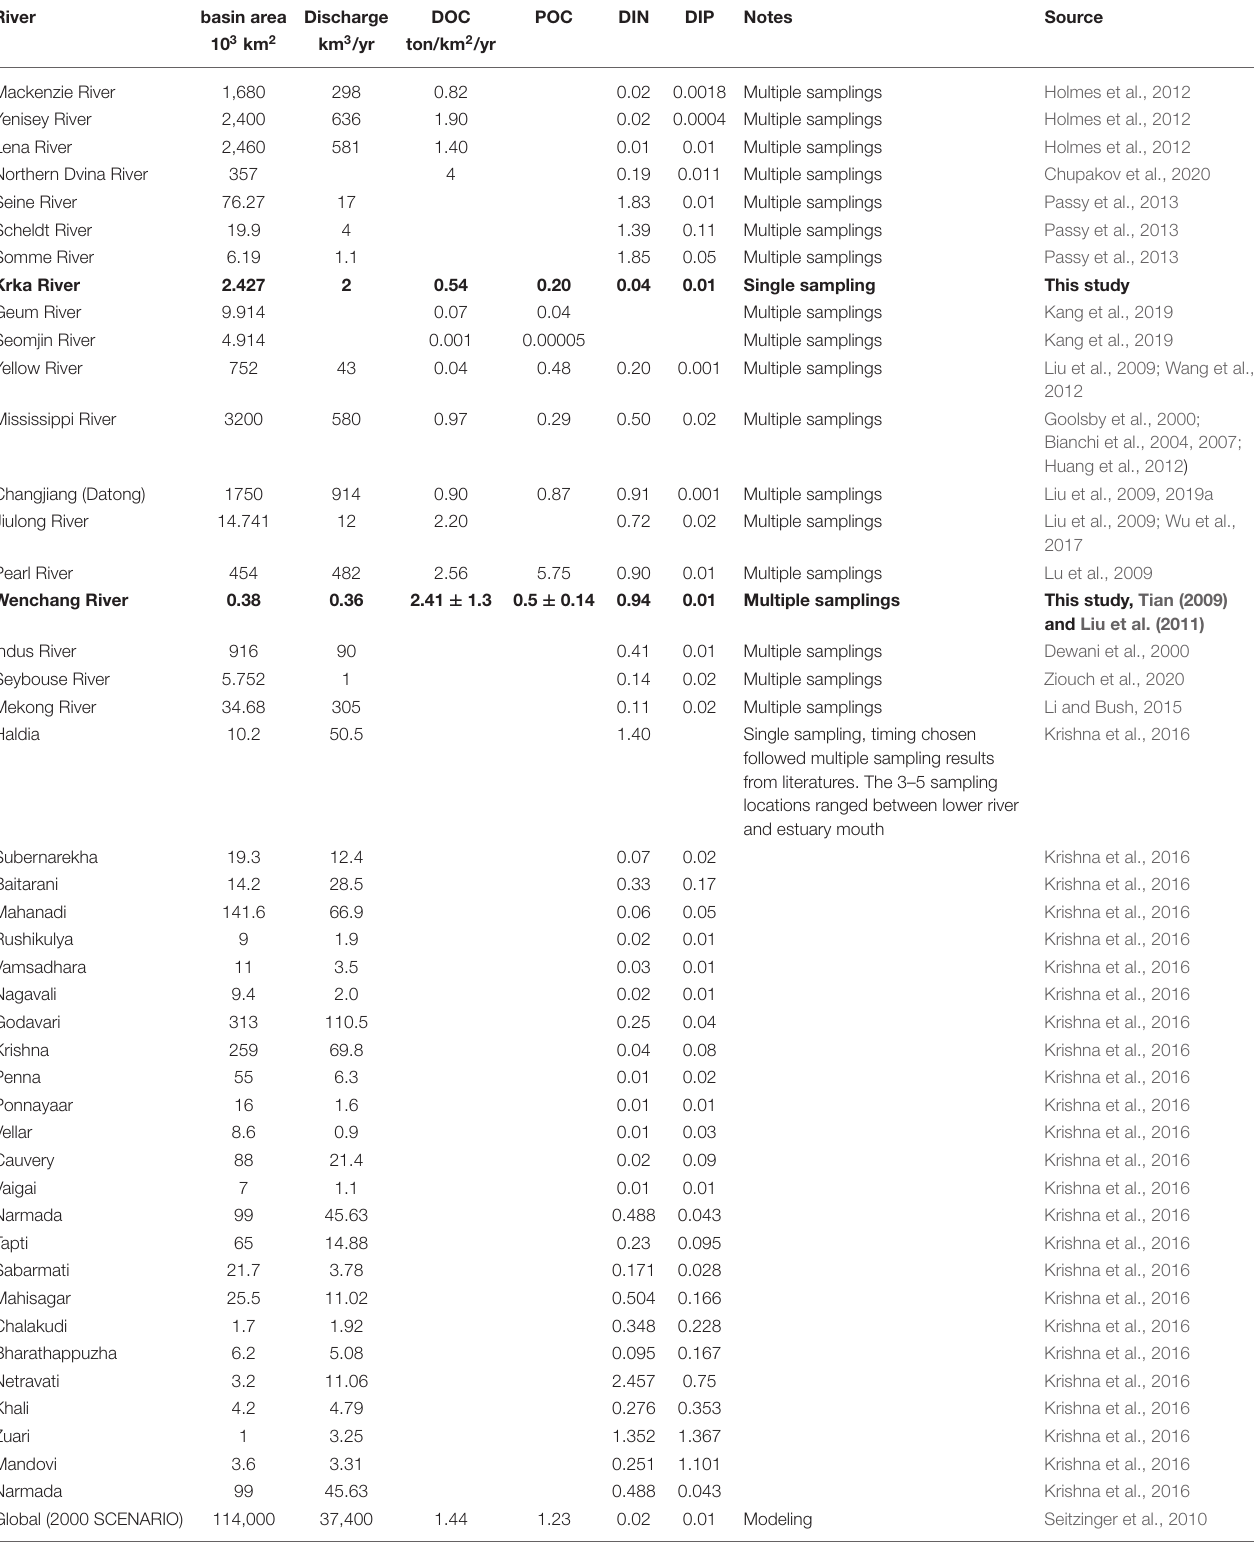
TABLE 4 | Basin area, discharge, and estimate of OM and nutrient yields for the Wenchang and the Krka Rivers and a comparison with other world